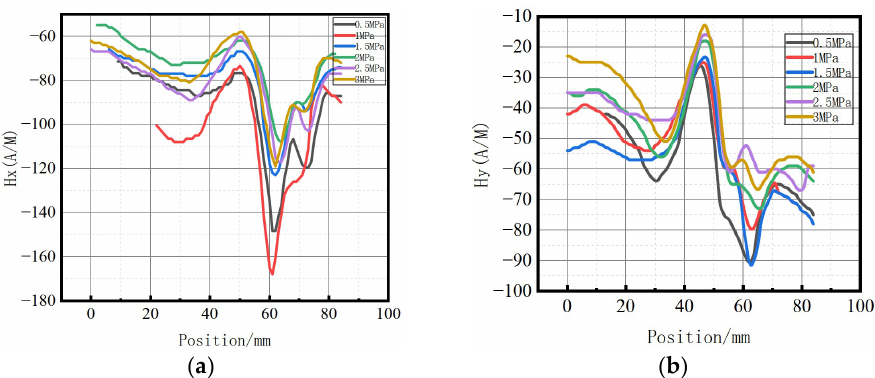
Figure 25. Magnetic signal changes at the weld with internal pressures. ( a ) Axial component of weak magnetic signal; ( b ) radial component of weak magnetic signal.